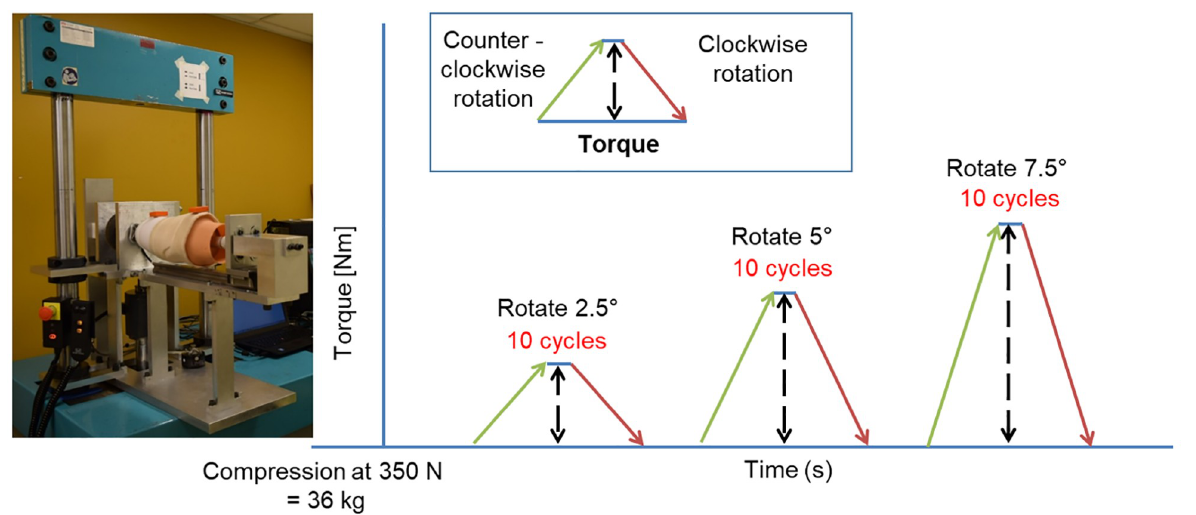
Fig 4. Protocol used for rotation testing: After pre-compressing the socket and mock residual limb to 350 N, the socket was rotated around the mock residual limb and subjected to six trials of ten cycles at three increasing rotation angles.